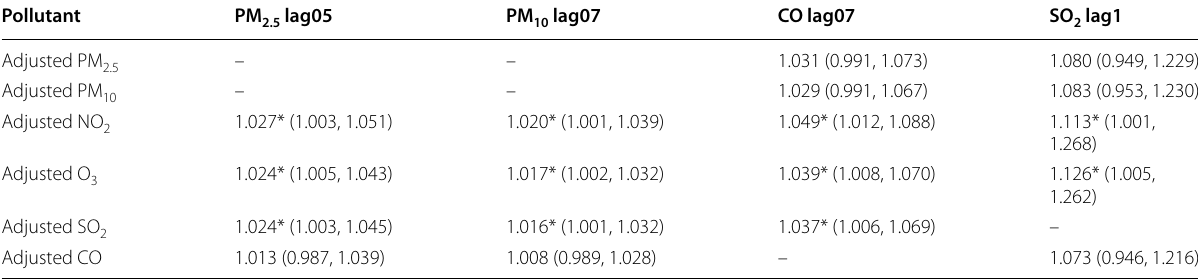
Table 2 Association of patients with atrial fibrillation with air pollutants in a dual-pollutant model